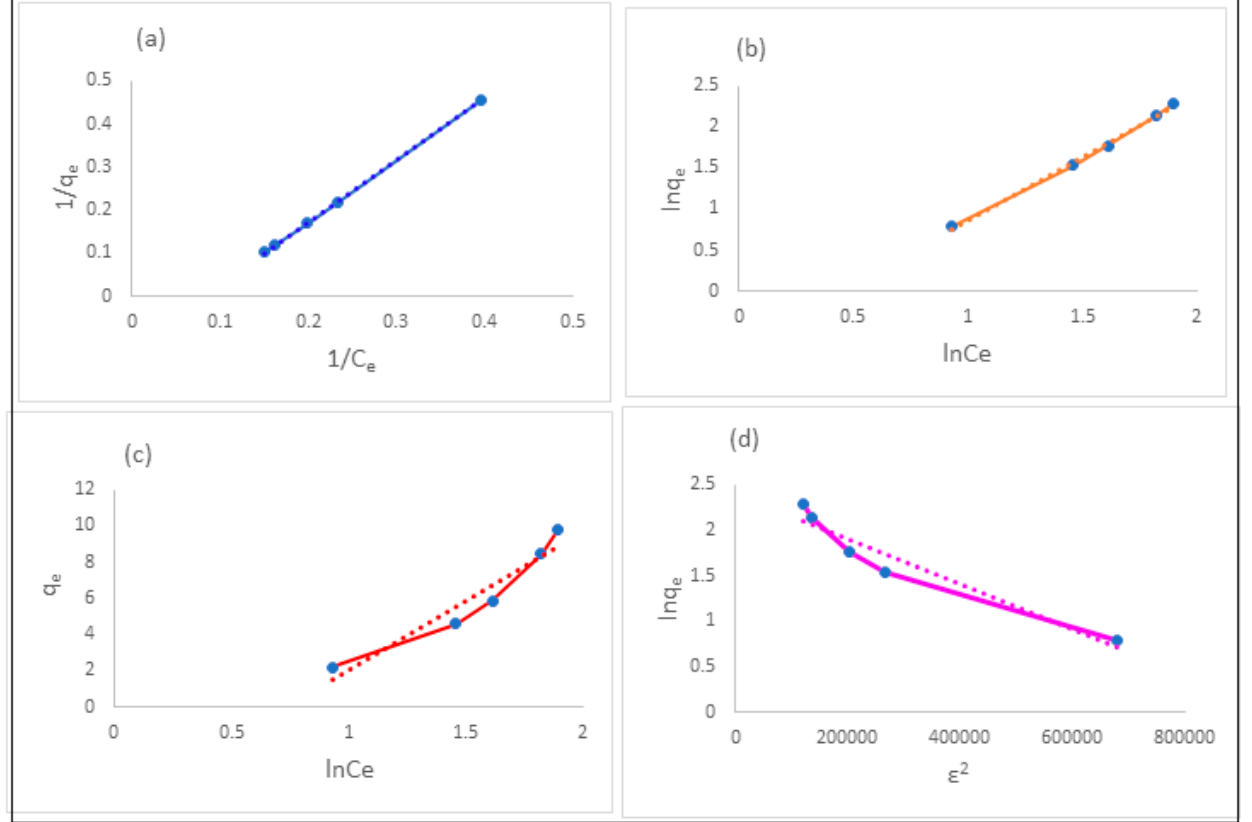
Figure 8. ( a ) Langmuir; ( b ) Freundlich; ( c ) Temkin; ( d ) Dubinin–Radushkevich adsorption isotherm plots for the adsorption of citalopram HBr onto citric-acid-modified Moringa peregrina leaf adsorbent at room temperature.